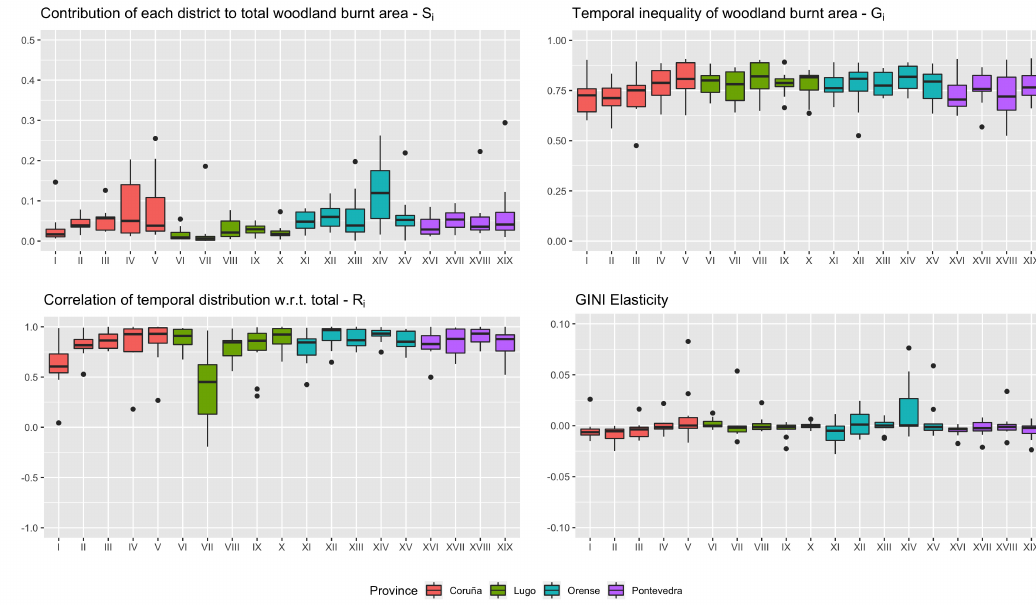
Figure 10. Temporal Gini decomposition of burned woodland area per forest district.